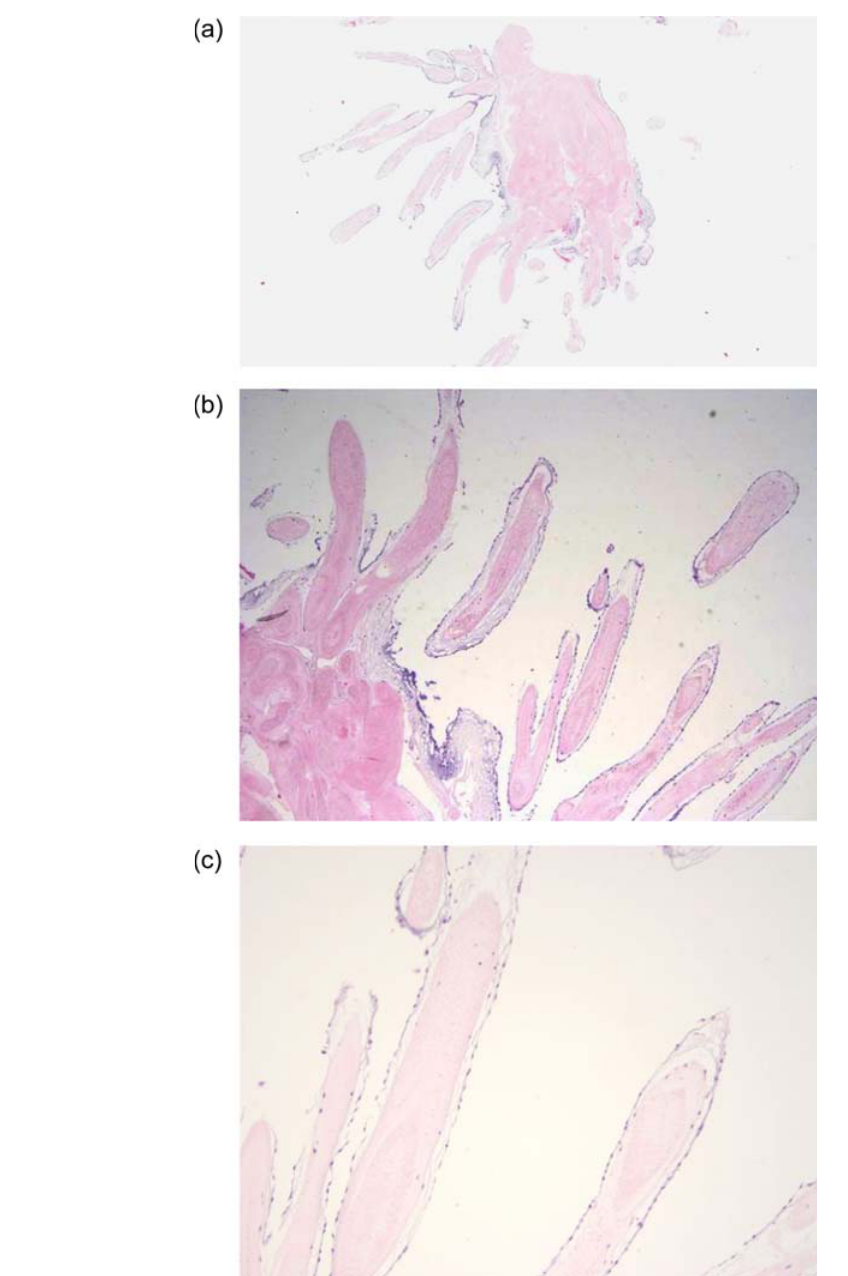
Figure 4. Photomicrograph of papillary